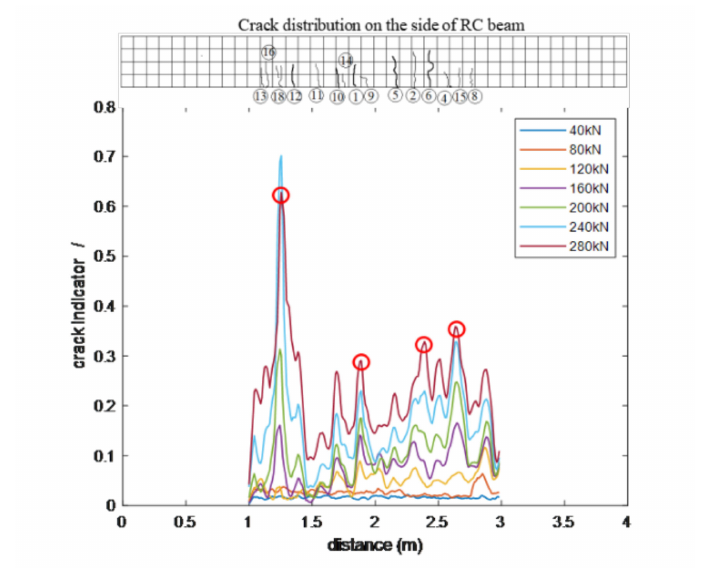
Figure 24. Crack indicator along fiber G5 under di ff erent load levels.